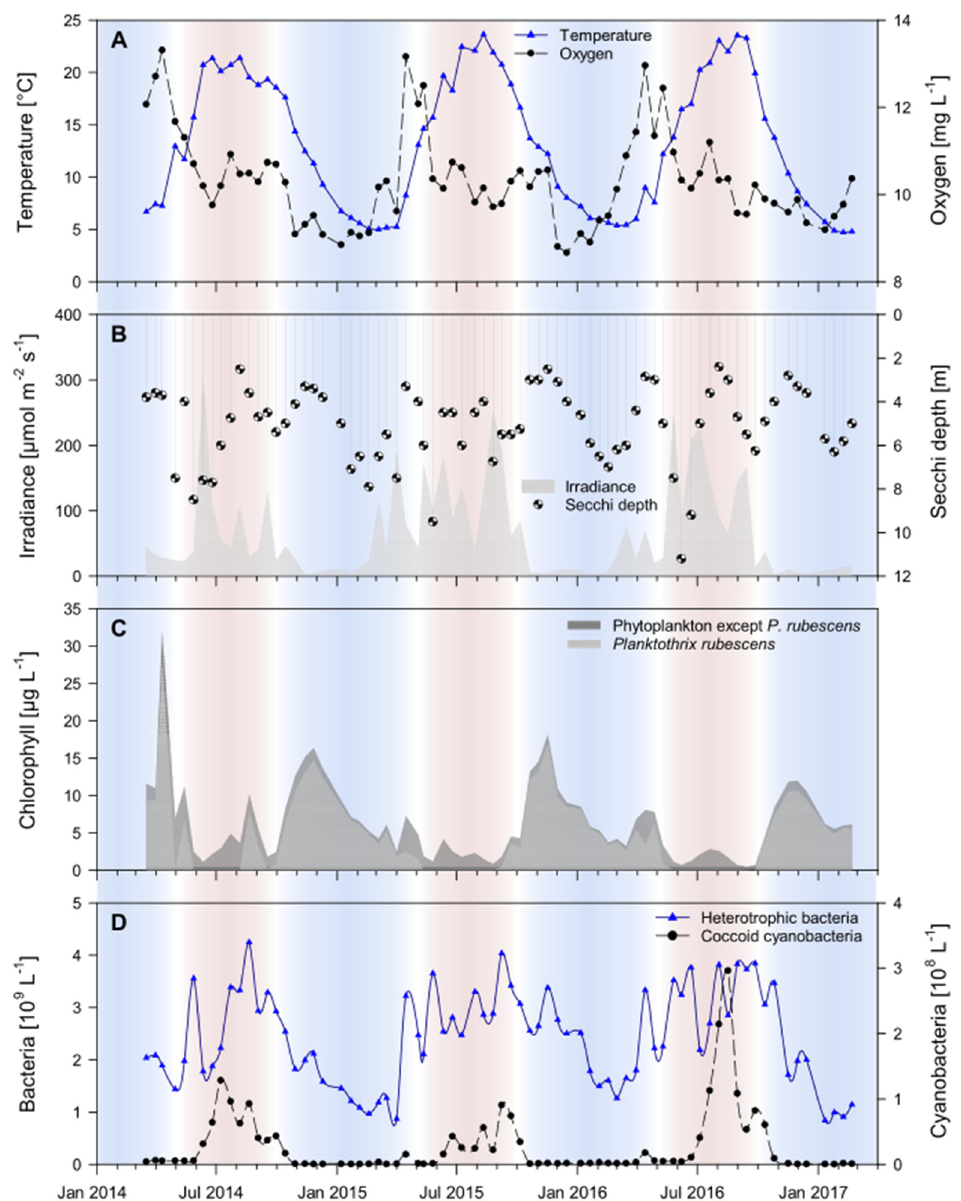
Figure 1. Time-series data of environmental parameters. Seasonally fluctuating parameters were measured throughout the three-year sampling campaign in the epilimnion of Lake Zurich. In all panels, cold season months are colored in blue and warm-season months in red. Panel ( A ) shows water temperature (blue line) and oxygen concentration (black line). Panel ( B ) shows irradiance (grey area) and the Secchi depth (data points). Panel ( C ) shows chlorophyll concentration of all phytoplankton (dark grey area) and the fraction of Planktothrix rubescens -related chlorophyll concentration among the total chlorophyll concentration (light grey area). Panel ( D ) shows cell counts of all heterotrophic bacteria (blue line) as well as of coccoid cyanobacteria (black line).